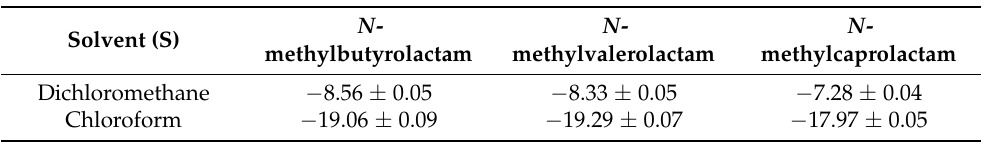
Table 4. Solution enthalpies of N -methylbutyrolactam, N -methylvalerolactam, N